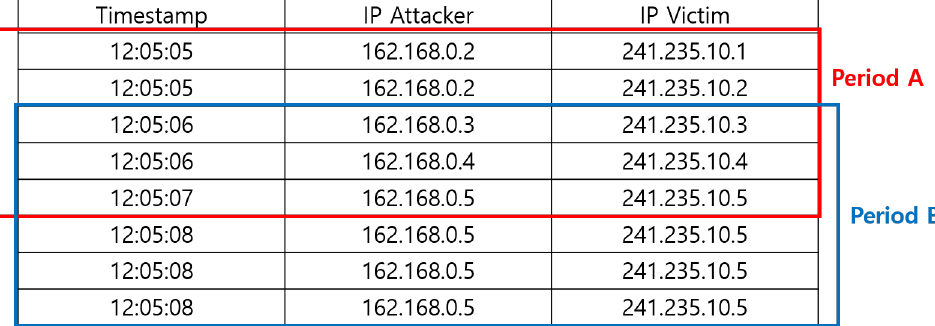
Figure 4. A simplified data sample to generate an